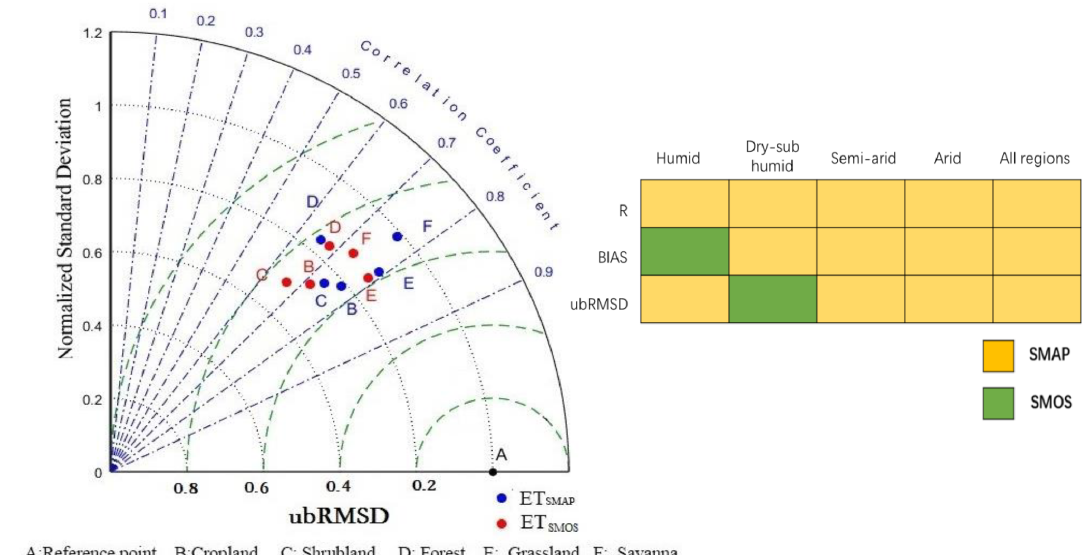
Figure 10. Taylor diagram (left) comparing ET simulations with observations at all 46 AmeriFlux sites at the daily time step between April 2015 and December 2018. Blue dots represent results based on assimilation with SMAP SSM only, and red dots represent results based on assimilation with SMOS SSM only. Reference points A and B–F correspond to the vegetation functional types (PFTs). The grid diagram (right) compares the evaluation indices of ET simulations with those of the observed values at all 46 AmeriFlux sites with different wet and dry zones at the daily time step; the yellow cells indicate that ET SMAP performs better in the metric, and green cells indicate that ET SMOS performs better in the